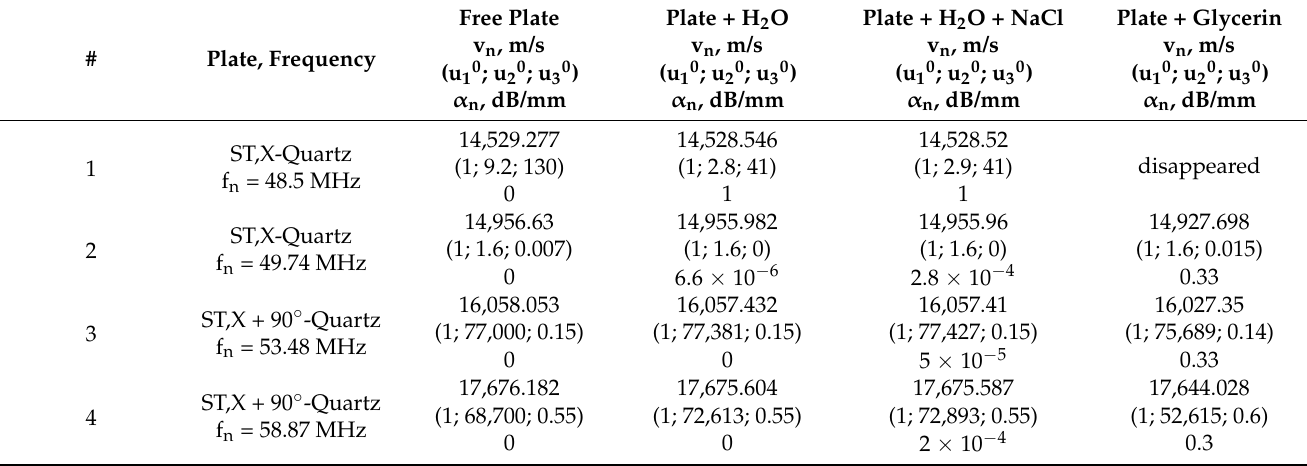
Table 3. The velocities v ph , normalized displacements u 10 , u 20 , u 30 at x 3 = 0 and attenuation coefficients α n of APM in quartz plates with two free faces and plates with one free–one liquid loaded faces. Plates: ST,X and ST,X + 90 ◦ -quartz with h/ λ = 1. Loadings: distilled H 2 O, water solution of NaCl (conductivity σ = 0.24 S/m), and pure glycerin (viscosity η = 1491 cP).